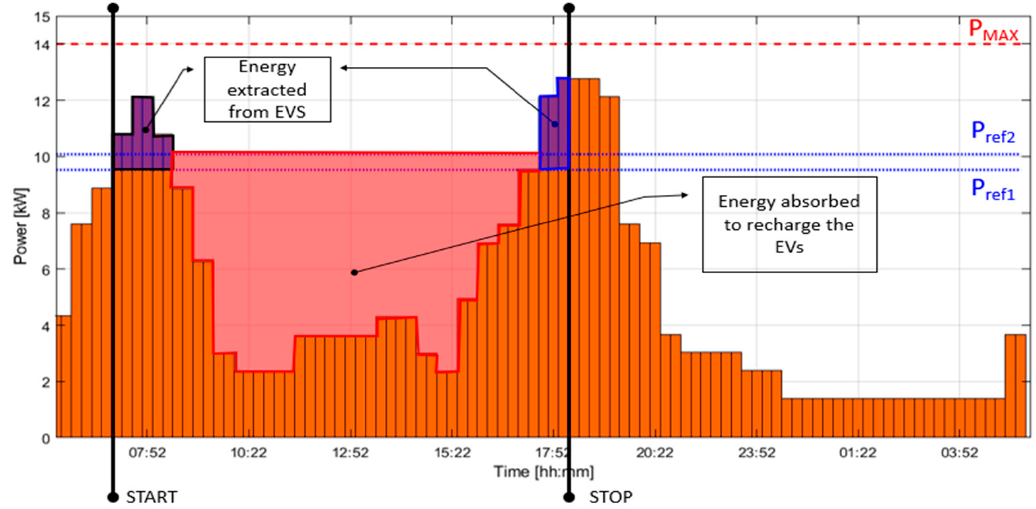
Figure 20. Operating principle of the peak shaving algorithm.